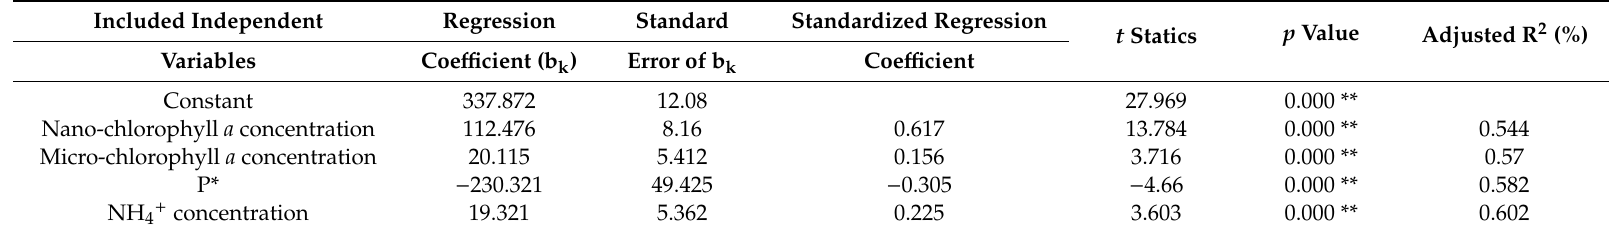
Table 4. Regression analysis results for the FM in Jaran Bay (**: p < 0.01, n =